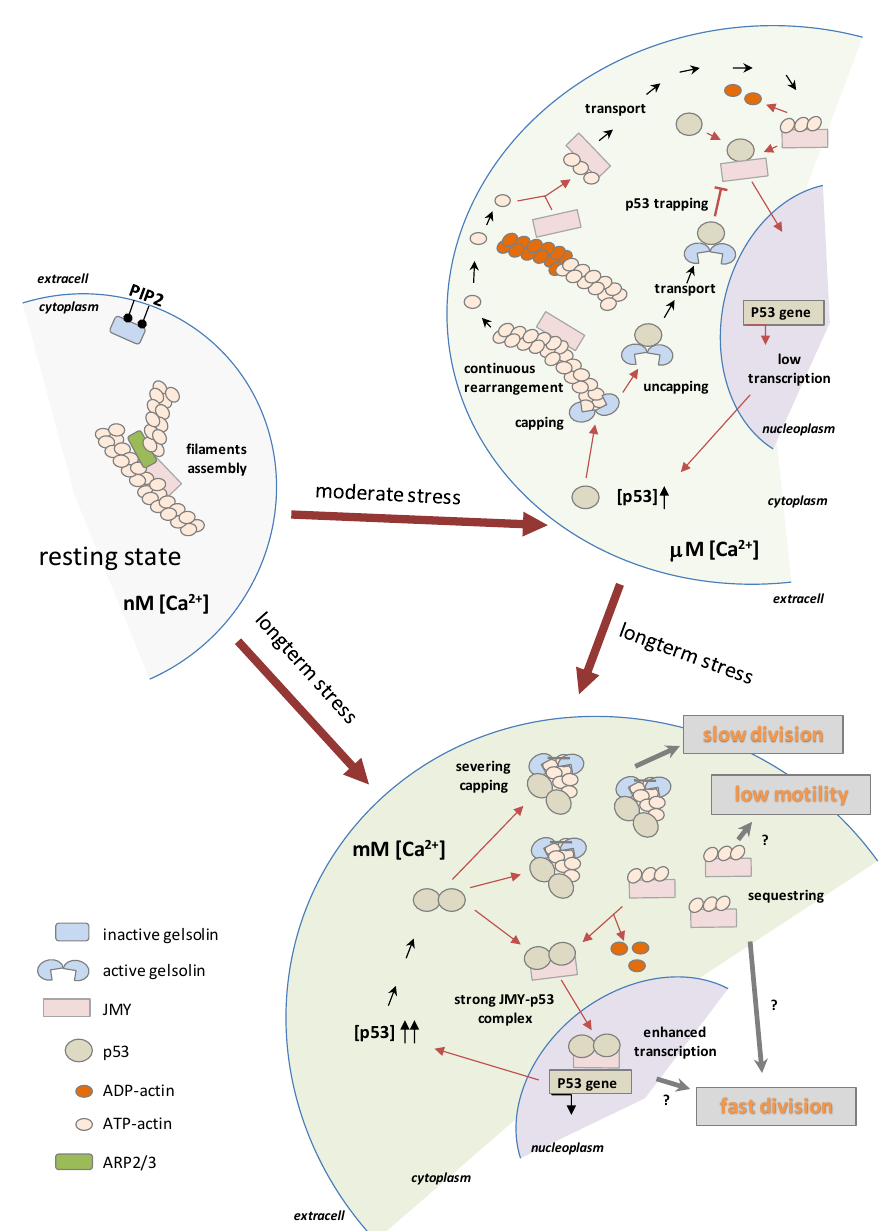
Figure 6. Hypothetical model of p53- and Ca 2+ -regulated function of GSN and JMY. The moderate stress caused by the micromolar Ca 2+ concentration activates the capping function of GSN and subsequently induces the continuous rearrangement of actin filaments. During short-term stress to the cell, de novo filament synthesis can be stopped, and thus JMY can be released from long-lasting filaments (mainly ADP–actin) and then transported into the nucleus. Increased levels of cytoplasmic p53 compete with actin in GSN and lead to uncapped filaments, thus trapped p53 cannot form complexes with JMY, and due to this, may prevent the nuclear transport of p53–JMY and cannot enhance the expression of p53. In the case of a long-term stress, the millimolar Ca 2+ concentration induces the total activity of GSN, and thus, through the severing and capping of filaments, results a slow division of cells, all while the JMY sequestering of actin monomers takes them out of the de novo filament synthesis and results in slow cell motility. A high Ca 2+ level initializes p53 dimerization, and the dimer competes with actin in JMY which helps p53 – JMY cotransport into the nucleus, thereby initializing enhanced p53 expression. (symbols of “?” indicate the unknown relationships)